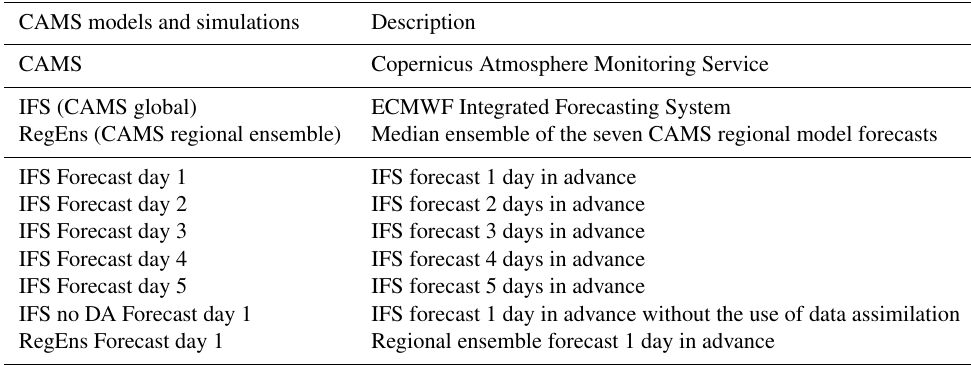
Table 1. CAMS models and simulations used in the present